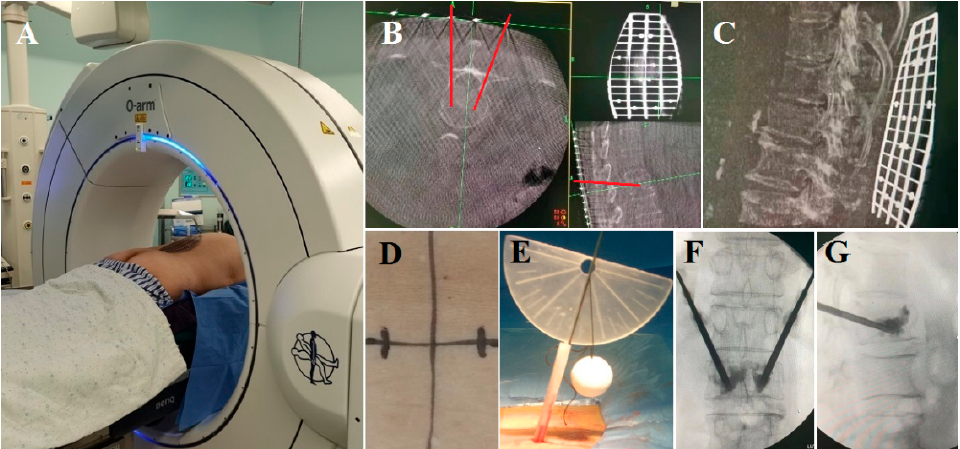
Figure 3. Intraoperative images of a 68-year-old woman with an L1 vertebral compression fracture. ( A – C ) Three-dimensional CT scans carried out using the O-arm were used to perform preoperative planning. ( D ) The entry point on the skin was determined using the body surface locator before the operation. ( E ) A 3D-printed guide device was used to determine the bone puncture point and insertion angle of the trajectory during the operation. ( F , G ) Cement was injected into the vertebra through bilateral PKP.